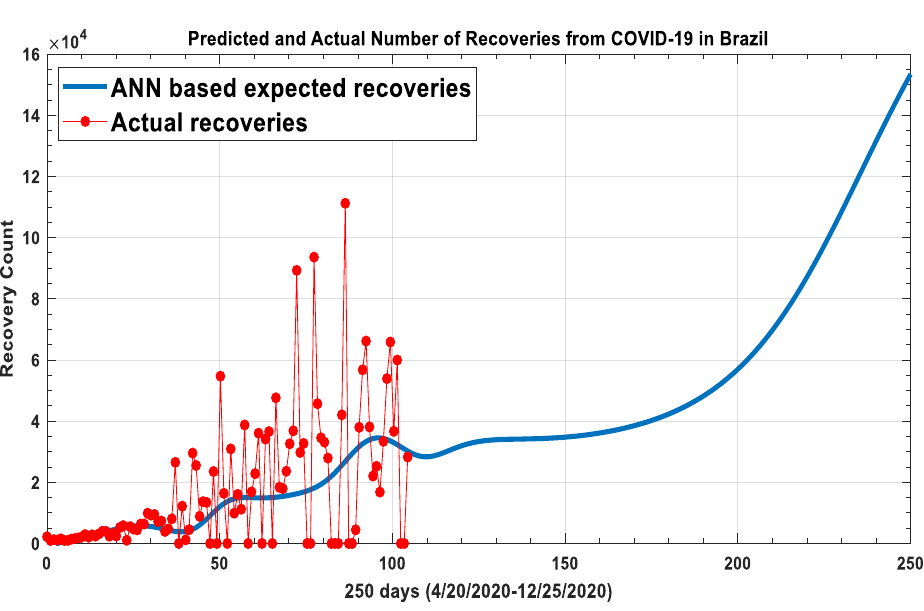
Figure 5. The training data and predicted data of COVID-19 deaths in Brazil. Moreover, we have used the correlation confident between the testing data that cov- ered the duration from 4 August 2020, to 22 November 2020, and the corresponding ANN values, as shown in Figure 6. Additionally, the nonlinear regression equations of the test- ing data are illustrated in Figure 6. The nonlinear regression equations will help to under- stand the relation between the observed values and expected values. The results show that the expected number of infections, recoveries, and deaths is much higher than an- nounced due to the insufficient number of tests and the spread of disease among indige- nous and poor communities.